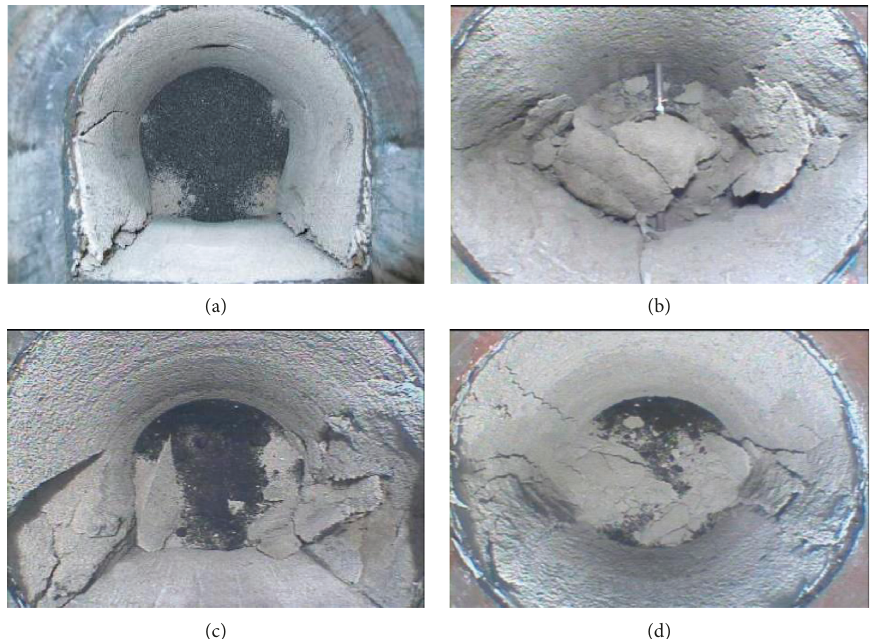
Figure 20: Model tunnels after load-testing. (a) Tunnel T1. (b) Tunnel T2. (c) Tunnel T3. (d) Tunnel